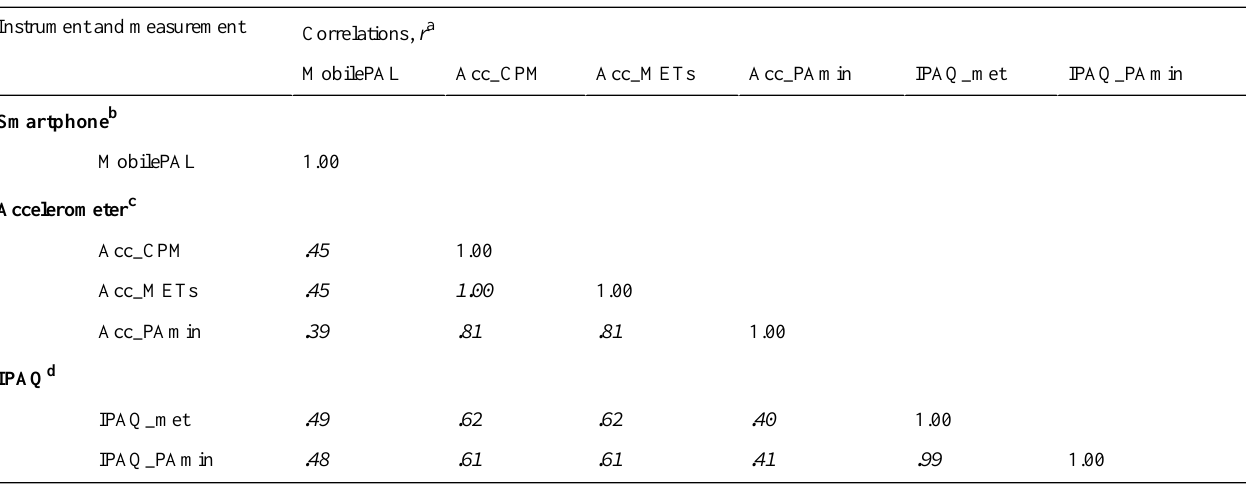
Table 4. Correlations between 3 different instruments, the smartphone, the accelerometer, and the International Physical Activity Questionnaire (IPAQ). Correlations, r a Instrument and